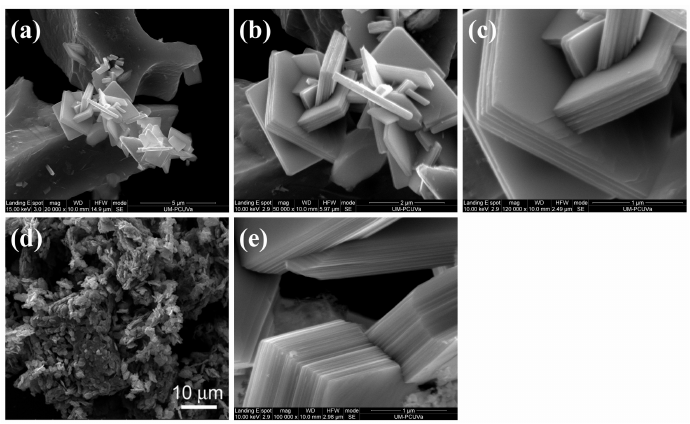
Figure 4. ( a – c ) SEM micrographs of α -MoO 3 crystals with a multi-layer stack structure at different magnifications (20,000 × , 50,000 × and 120,000 × , respectively); ( d ) SEM image of MoO 3 crystals obtained by calcination of commercial molybdic acid (MoO 3 · H 2 O); ( e ) SEM micrograph of α -MoO 3 stacking with 44